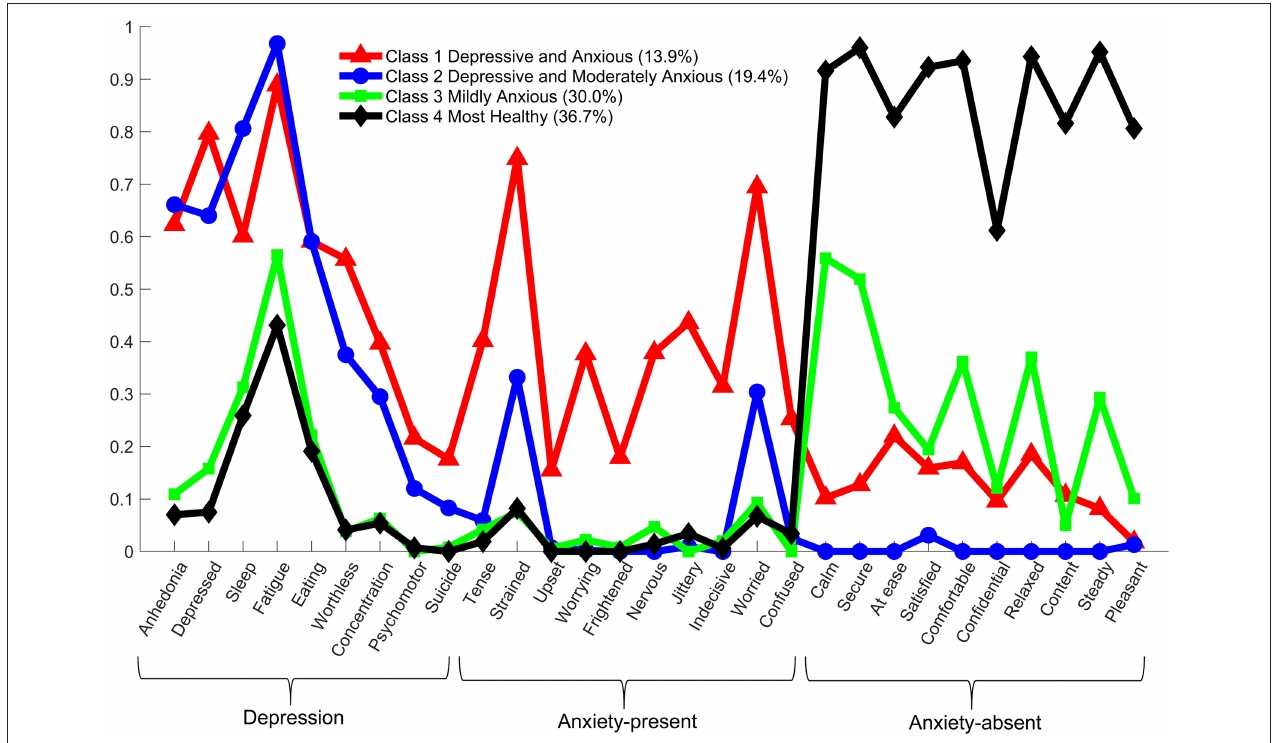
FIGURE 1 | The probability of symptom endorsement by each latent class (i.e., conditional